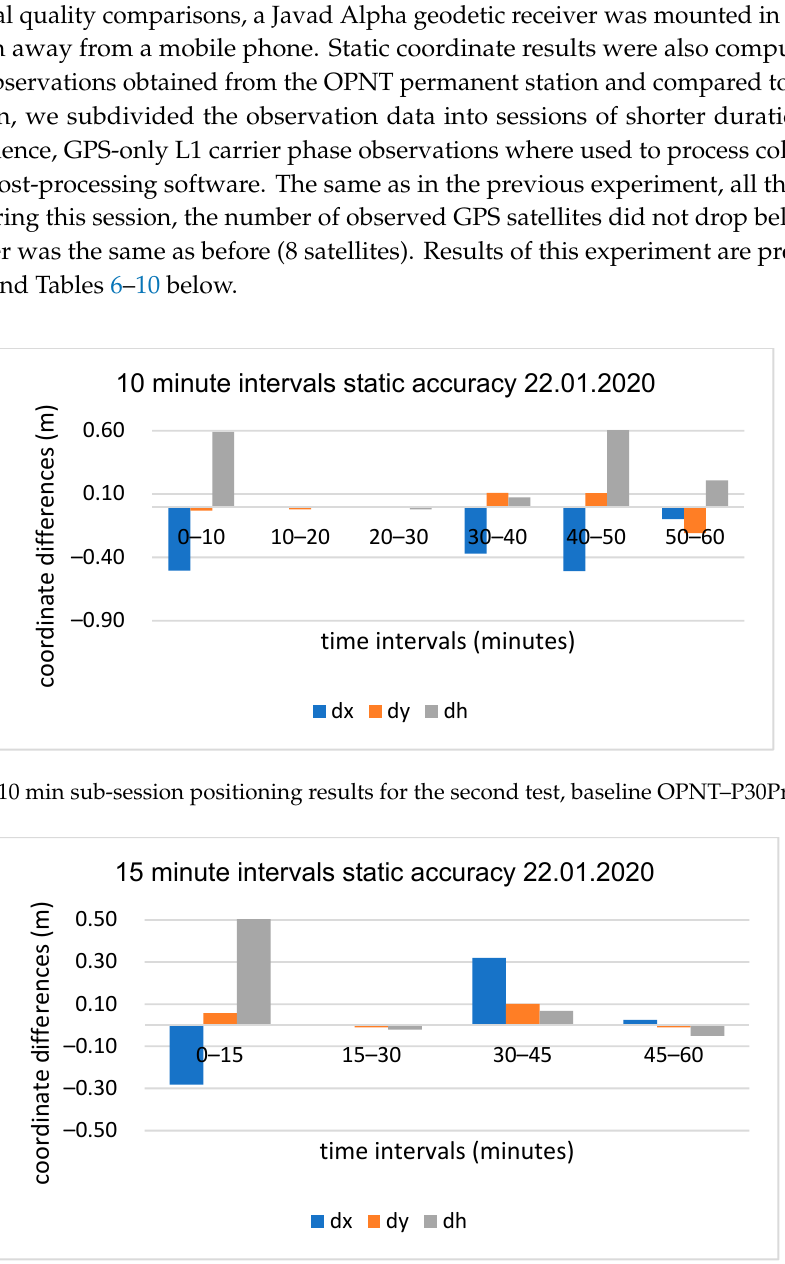
Figure 12. 15 min sub-session positioning results for the second test, baseline OPNT–P30Pro (4km).